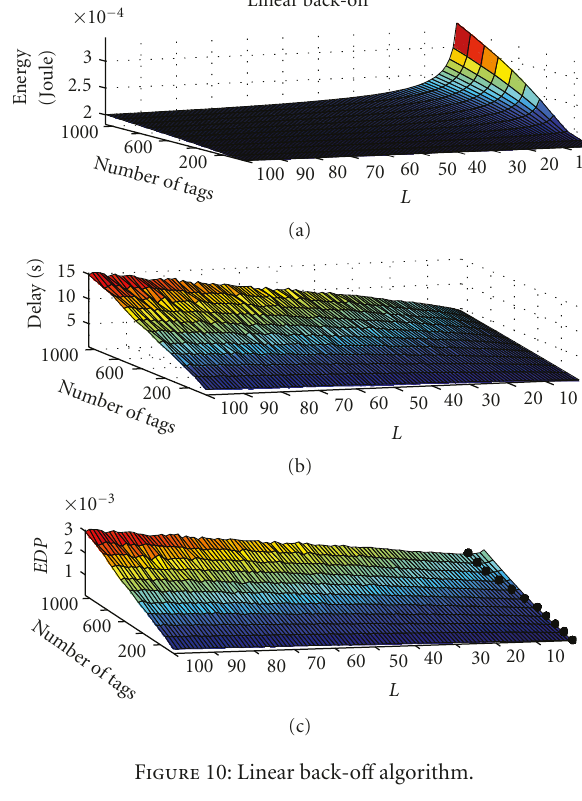
Figure 9: Simulationresults for constant back-o ff time: min Energy Consumption (a), min Delay (b), and Energy-Delay Product (c) as a function of the coe ffi cient C , and the number of tags.